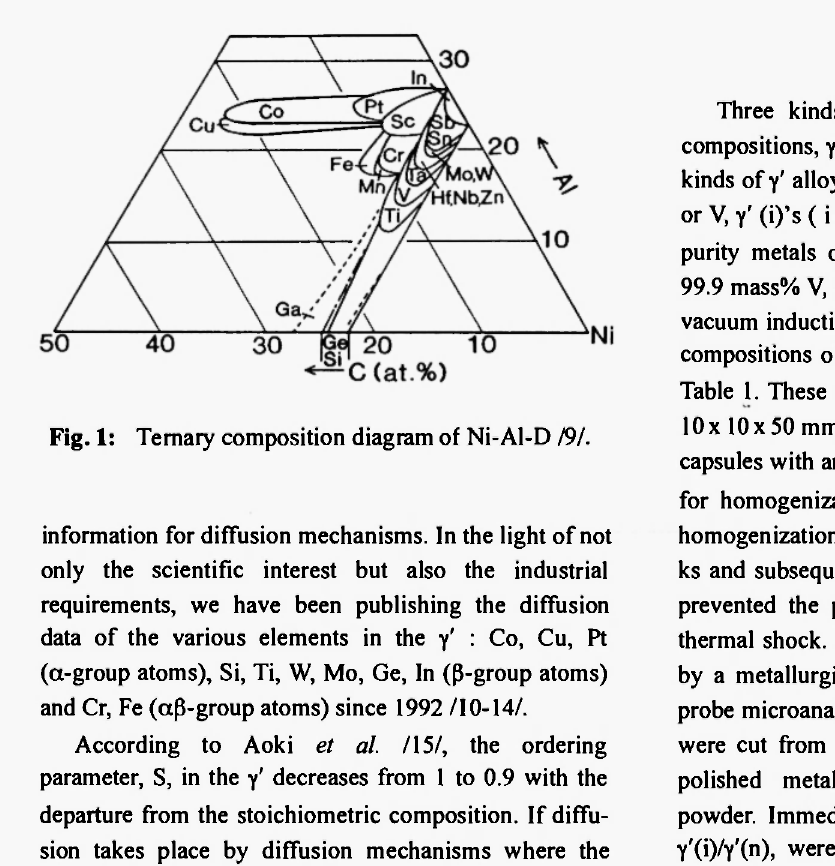
Fig. 1: Ternary composition diagram of Ni-Al-D 191.